Question: Condense the content of this figure into a single sentence.
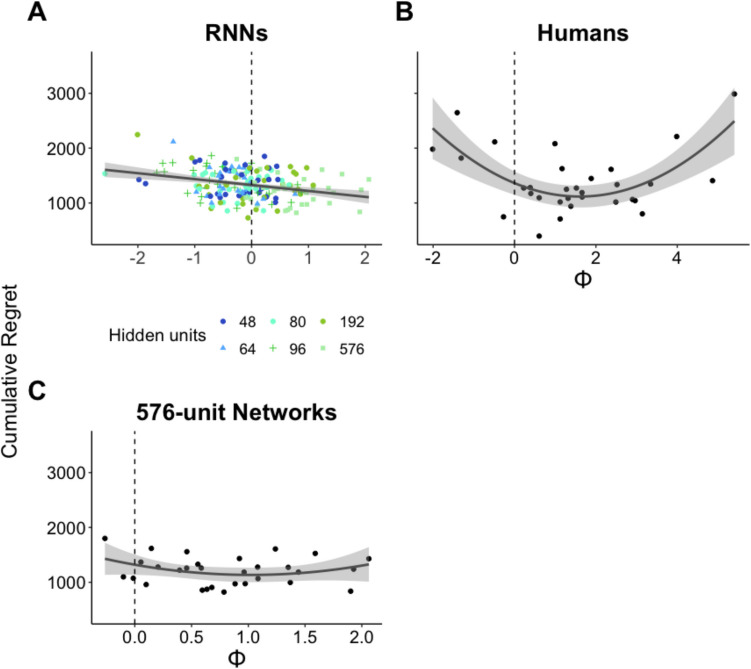
Answer: Association between overall performance and directed exploration in RNNs vs. human learners. \documentclass[12pt]{minimal} \usepackage{amsmath} \usepackage{wasysym} \usepackage{amsfonts} \usepackage{amssymb} \usepackage{amsbsy} \usepackage{mathrsfs} \usepackage{upgreek} \setlength{\oddsidemargin}{-69pt} \begin{document}$$\Phi$$\end{document} Φ = Exploration bonus parameter. ( A ) Grey line denotes the relationship between directed exploration and overall performance across all groups of RNNs (color-coded). Data points represent the average regret of each RNN across runs. ( B ) Grey line denotes the relationship between directed exploration and overall performance in the group of human learners. Data points represent the regret of each participant in a single run (placebo condition; Chakroun et al., 2020 ). ( C ) Grey line denotes the relationship between directed exploration and overall performance within the group of 576-unit networks